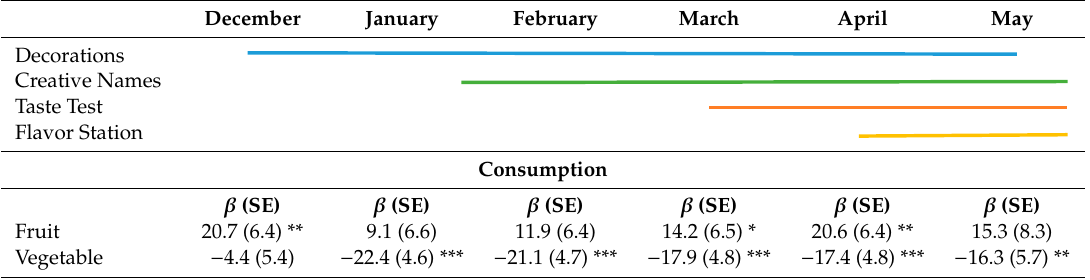
Table 3. Intervention component timeline and corresponding regression analyses examining changes in fruit and vegetable consumption over time at School 1.